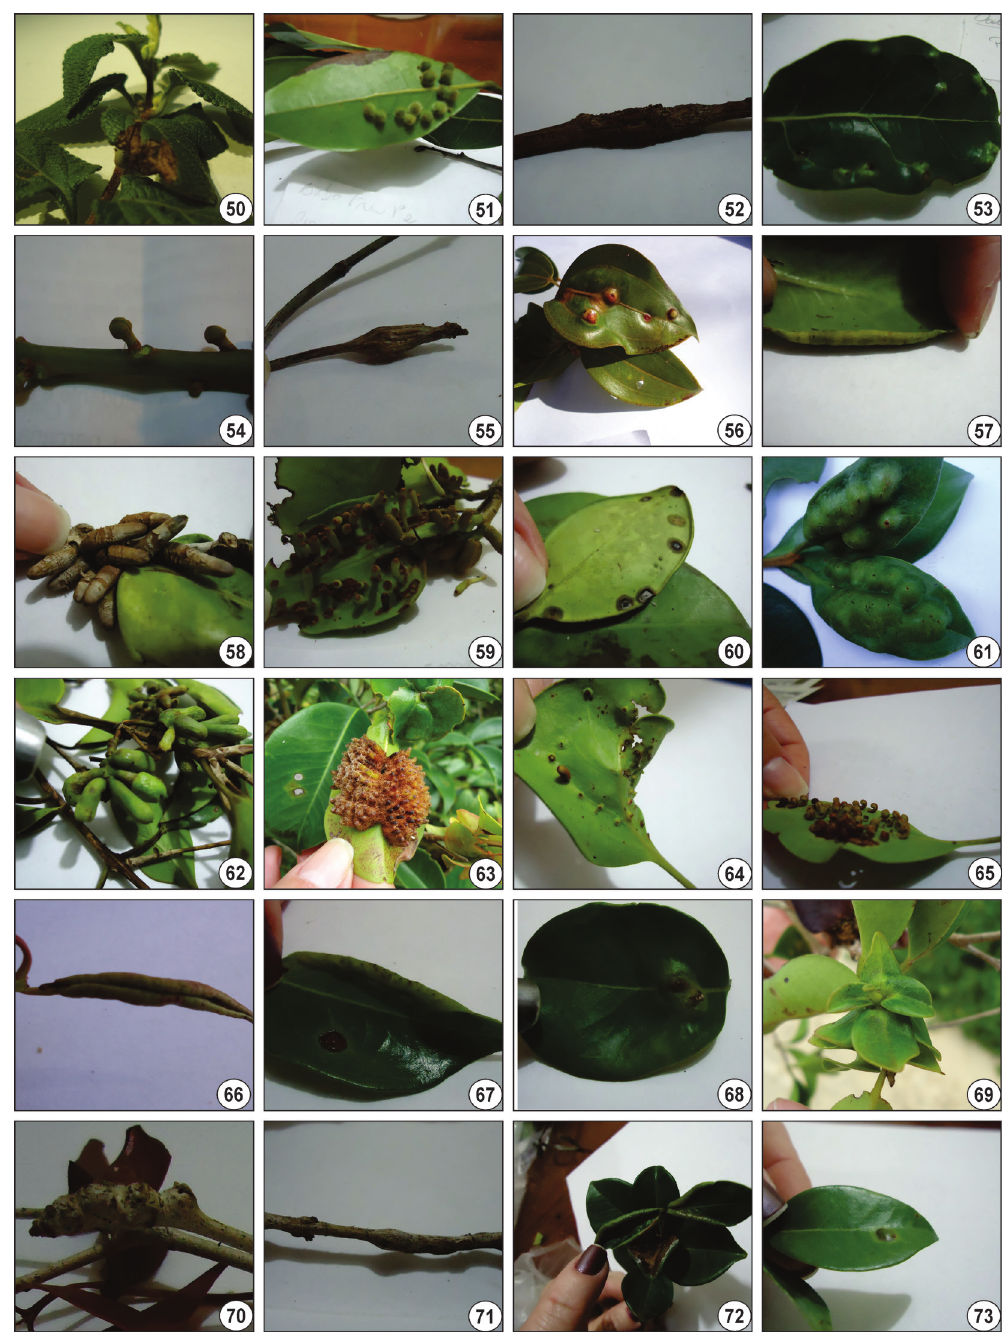
Figs. 50-73 - Galling insects from Parque Estadual da Costa do Sol and RPPN Fazenda Caruara (RJ, Brazil). 50, Hyptis sp., leaf vein gall. 51, Ocotea pulchella , globoid leaf gall. 52-53, Ocotea notata , 52, stem gall, 53, lenticular leaf gall. 54, Malpighiaceae sp., fruit gall. 55, Stigmaphyllon paralias , stem gall. 56, Miconia cinnamomifolia , leaf vein gall. 57-61, Eugenia astringens , 57, marginal roll, 58, conical leaf gall, 59, clavate gall, 60, lenticular leaf gall, 61, globoid leaf gall. 62-70, Eugenia copacabanensis , 62, bud gall, 63, conical leaf gall, 64, conical gall, 65, spiral leaf gall, 66, leaf fold, 67, marginal roll, 68, leaf vein gall, 69, rosette gall, 70, stem gall. 71, Eugenia punicifolia , stem gall. 72, Eugenia selloi , marginal roll. 73, Eugenia uniflora , lenticular leaf